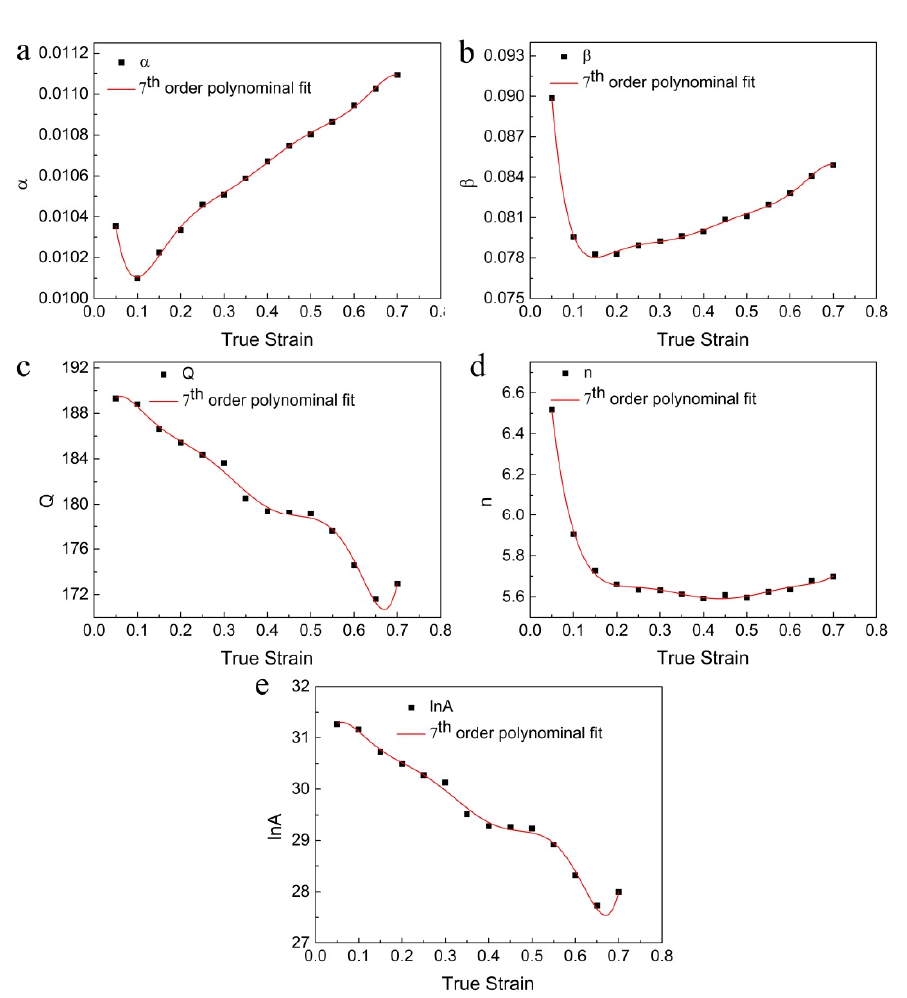
Figure 4. Relationships between true strain and ( a ) α , ( b ) β , ( c ) Q , ( d ) n , and ( e ) ln A by a seventh-order polynomial fitting.